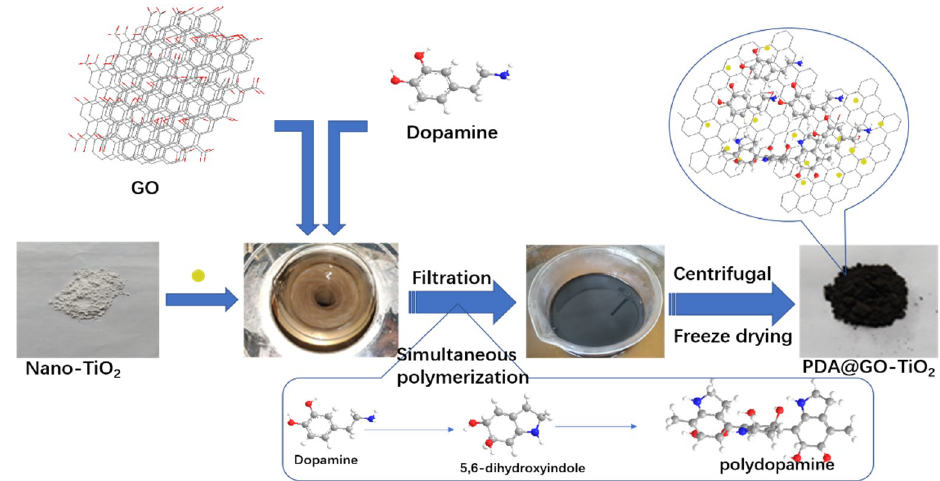
Figure 1. Schematic diagram of the preparation process of nano-polydopamine (PDA)@graphene oxide-TiO 2 (GO-TiO 2 ) composites.